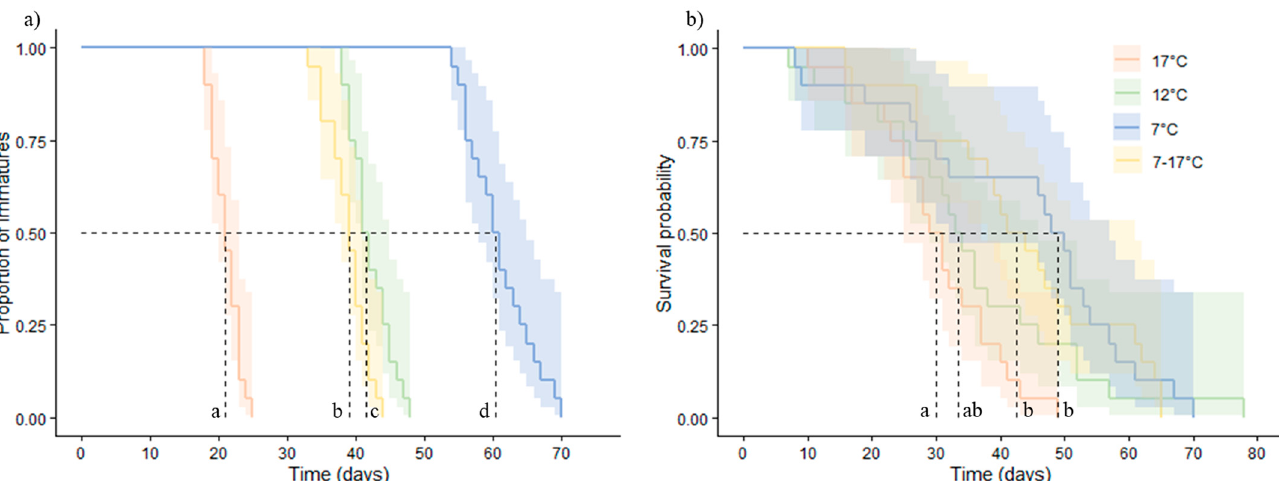
Figure 2. Proportion of immatures (i.e., development time to adulthood) ( a ) and adult survival probability ( b ) of Aphidius matricariae parasitoids exposed to three constant temperature regimes (7 °C, 12 °C, and 17 °C) and one fluctuating temperature regime (7–17 °C) for data of the two sexes pooled together. Dotted lines represent the median estimate for each temperature. Colored areas represent 95% CIs around estimates for each temperature. Lowerscript letters indicate significant differences ( p < 0.05) among temperature regimes for each measured parameter. N = 20.